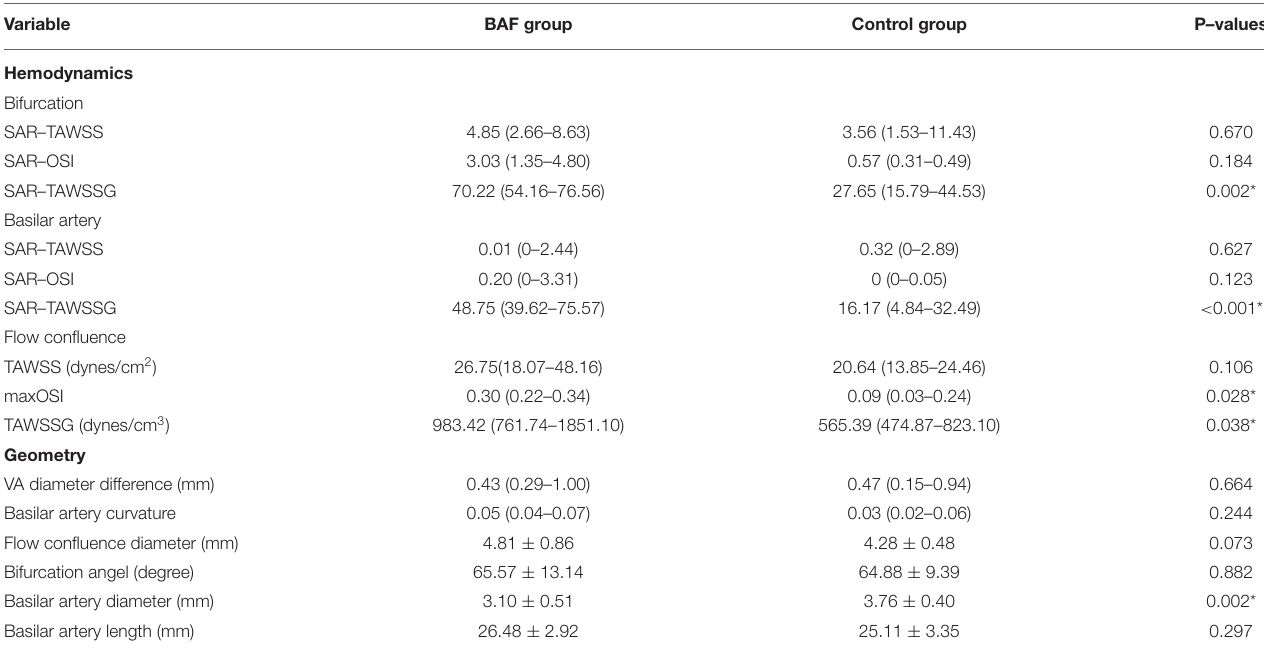
TABLE 2 | Results of hemodynamic and morphological